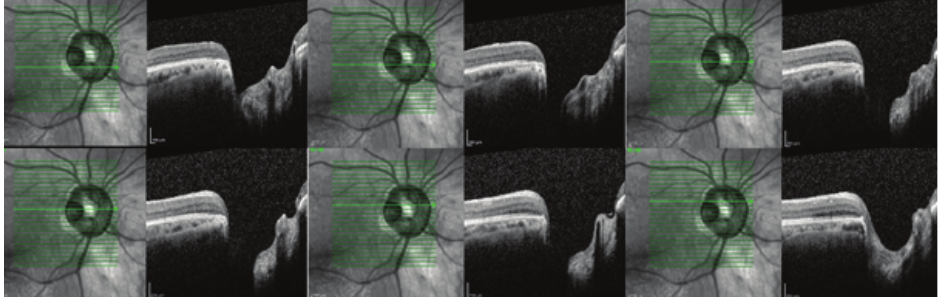
Figure 3. Horizontal sections of the spectral domain optical coherence tomography scans show the relationship of the pit of the optic nerve (PON) with the retinochoroidal vein.